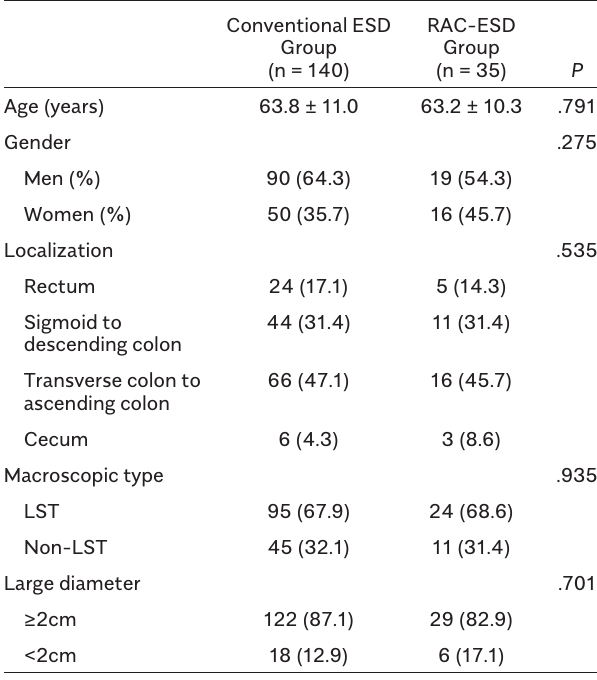
Table 2. Baseline Characteristics of Patients with Superficial Colorectal Neoplasms Treated by Conventional Endoscopic Submucosal Dissection (ESD) and Inner Traction-Facilitated ESD Using Rubber Band and Clip (RAC-ESD) in the Matched